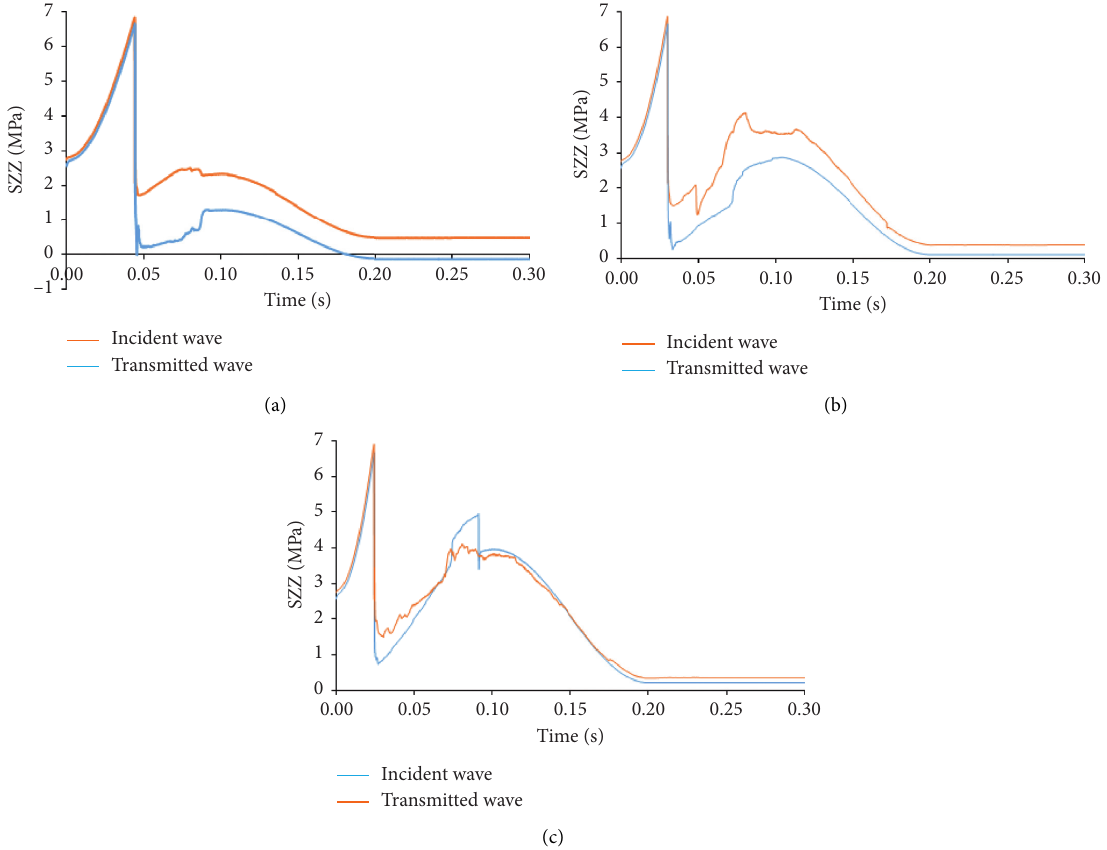
Figure 13: Vertical stress versus time curves for different dynamic disturbance intensity (LD � 0.4): (a) 10MPa; (b) 20MPa; (c)